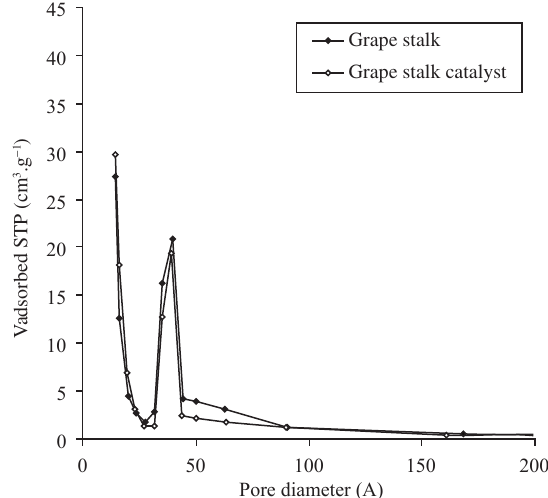
Figure 4. Pore size distribution for grape stalk AC support and